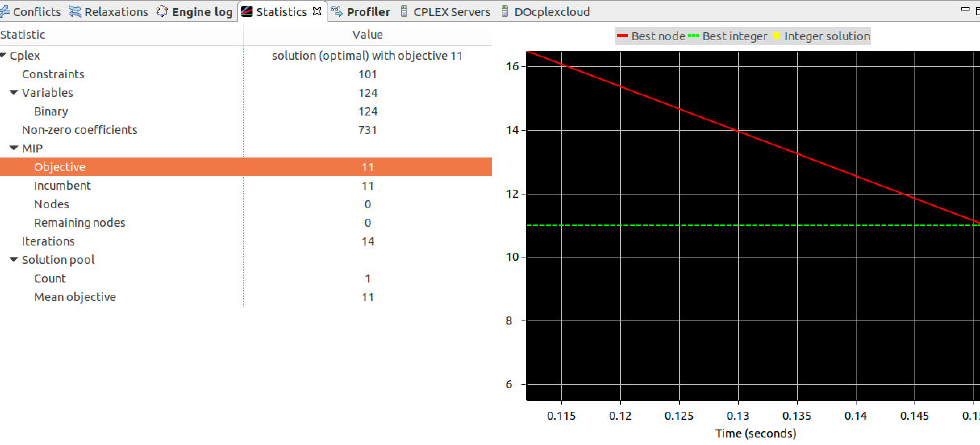
Figure 12. Cplex solution: